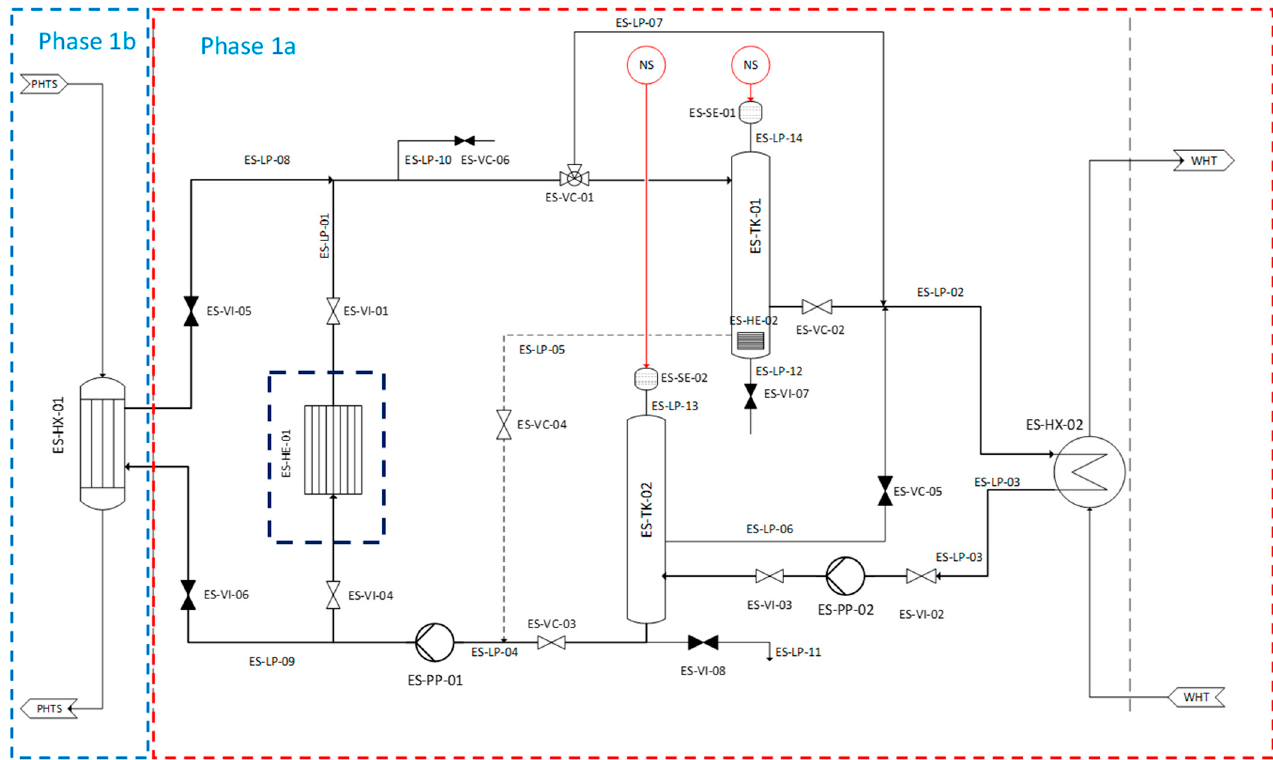
Figure 5. Pipe and Instrumentation Diagram of Phase 1 of the HELOKA-US system. Phase 1a energy storage system (ES) and nitrogen gas covering system (NS) components are enclosed in the red frame, and Phase 1b components are in the blue frame.